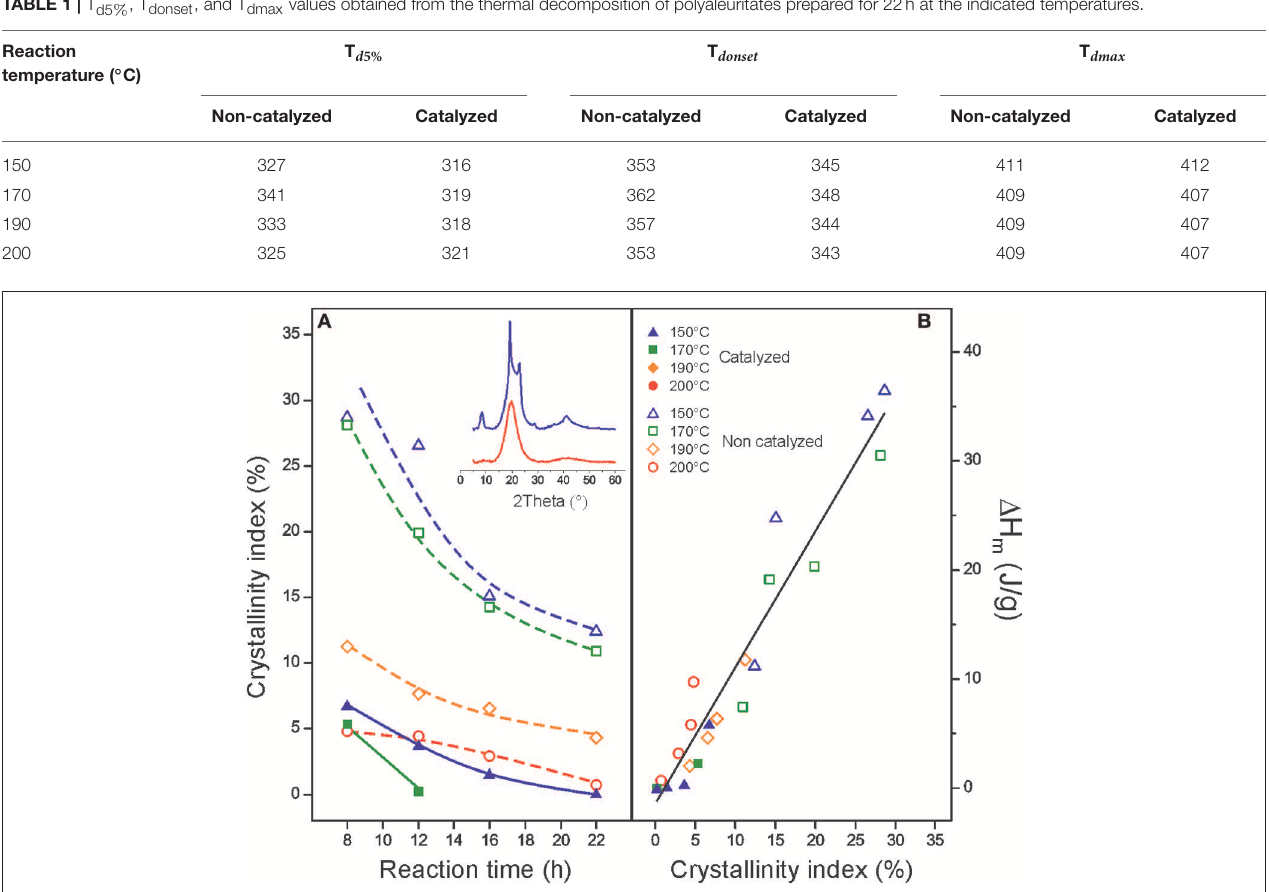
FIGURE 4 | (A) Crystallinity values calculated from XRD data of polyaleuritates as a function of the reaction time. The inset shows XRD patterns for samples prepared in air at 150 ◦ C (blue) and 200 ◦ C (red) for 8h. (B) Relationship between the melting enthalpy values and the XRD calculated crystallinity